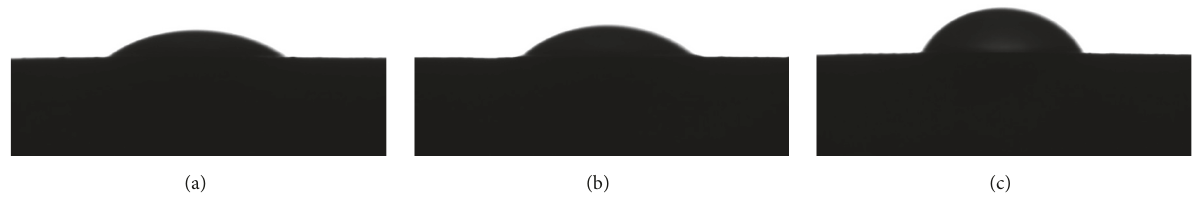
Figure 3: Profiles of sessile drops of ethylene glycol on the surfaces of: (a) Pal-1, (b) Pal-2, and (c) Pal-3, respectively.